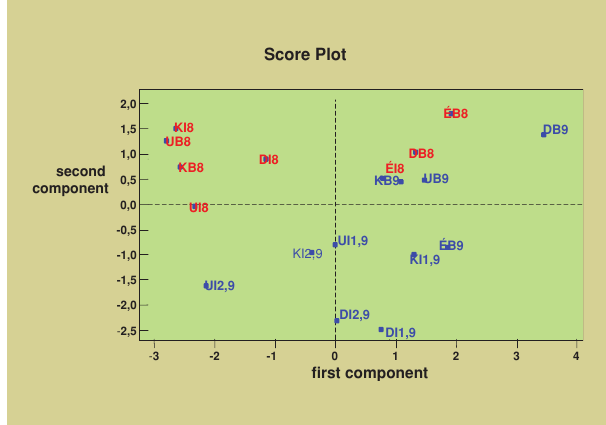
Figure 1: Total phenols of sour cherries in the cultivation seasons of 2008 and 2009.